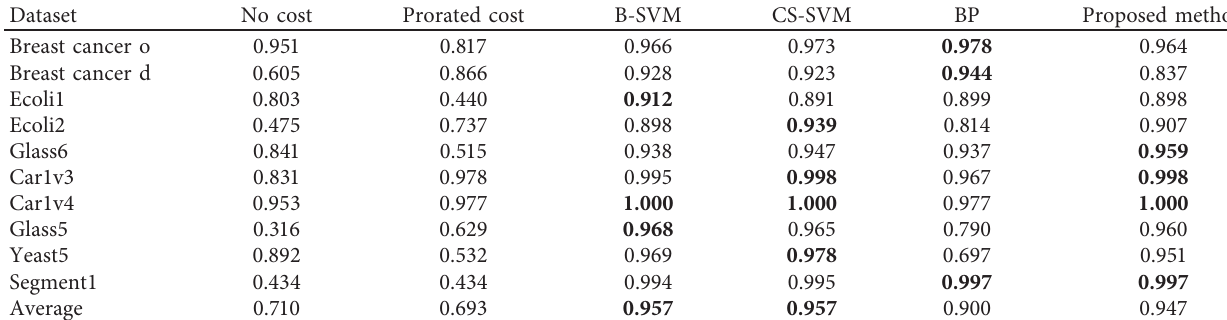
Table 5: g -means index.